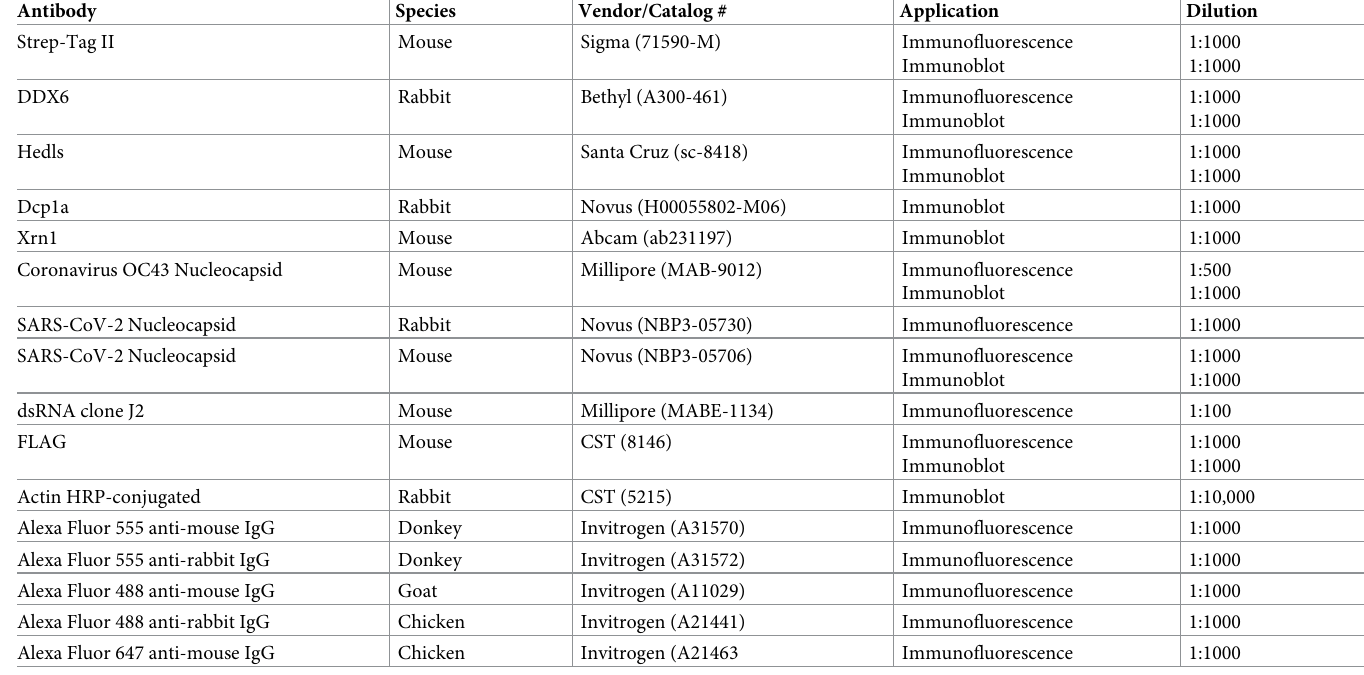
During image acquisition, exposure time was kept consistent within an independent experiment. Immunofluorescence (IF) RNA Fluorescent In Situ Hybridization (FISH) IF-FISH was performed according to manufacturer’s protocol (Stellaris IF-FISH protocol). Briefly, cells were fixed in 4% formaldehyde (Sigma-Aldrich) for 10 minutes then permeabi- lized with 0.1% Triton X-100 (Sigma-Aldrich) in PBS for 10 minutes. Primary Hedls antibody was diluted in PBS and incubated for 1 hour at room temp, following which an Alexa 488-con- jugated secondary antibody was likewise diluted in PBS and incubated for 1 hour at room temp. In some experiments, N protein was also stained using primary anti-N protein rabbit Table 2. Antibodies. Antibody Species